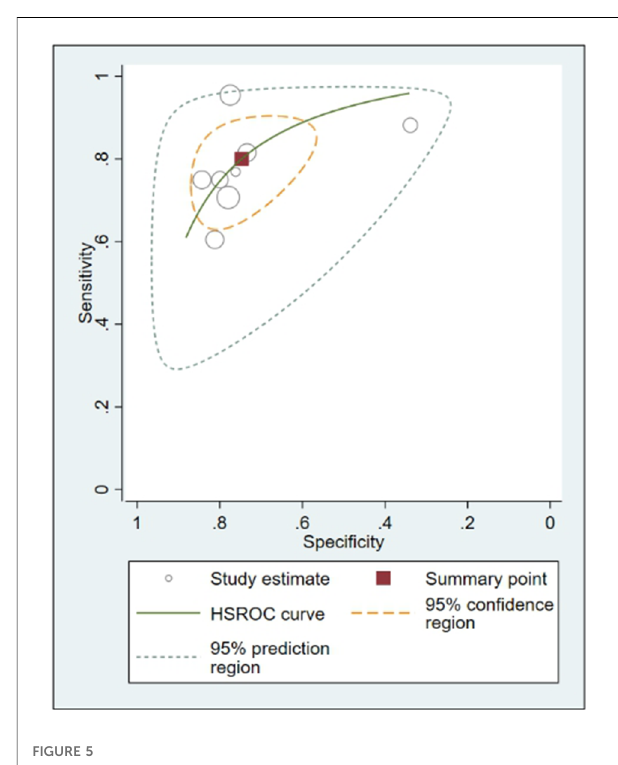
FIGURE 5 Hierarchical summary receiver-operating characteristic (HSROC)